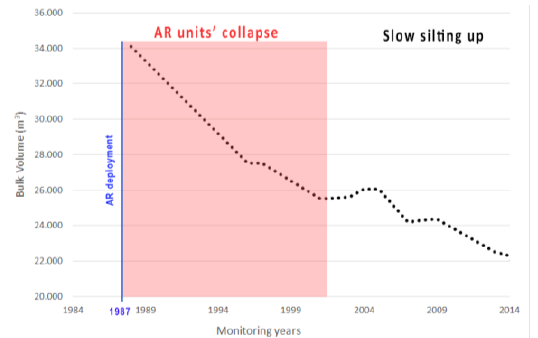
Figure 10. AR bulk volume assessment from AR